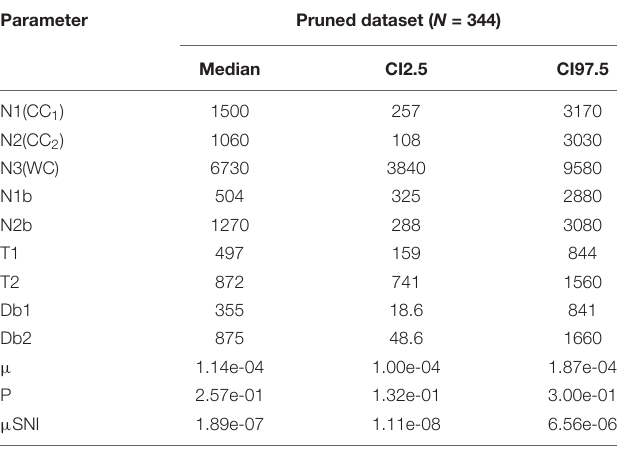
TABLE 3 | The parameter posterior distributions of model 2 under pruned dataset ( N = 344) in approximate Bayesian Computation analysis. Parameter Pruned dataset ( N = 344)